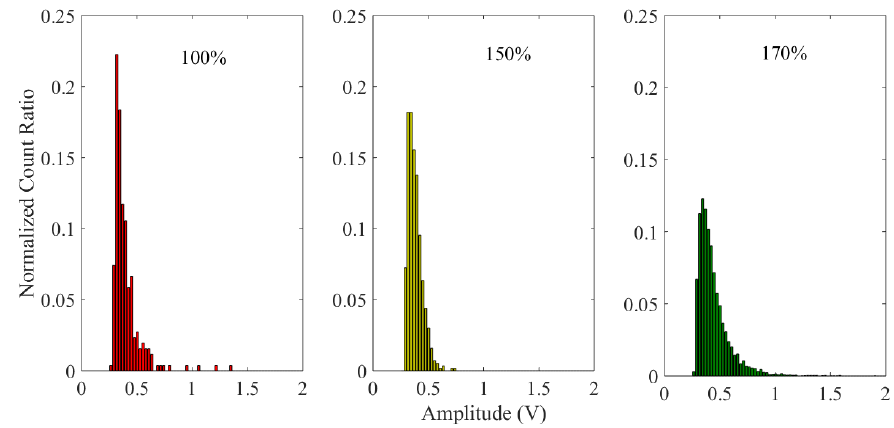
Figure 20. The normalized count ratio in different operation phases.